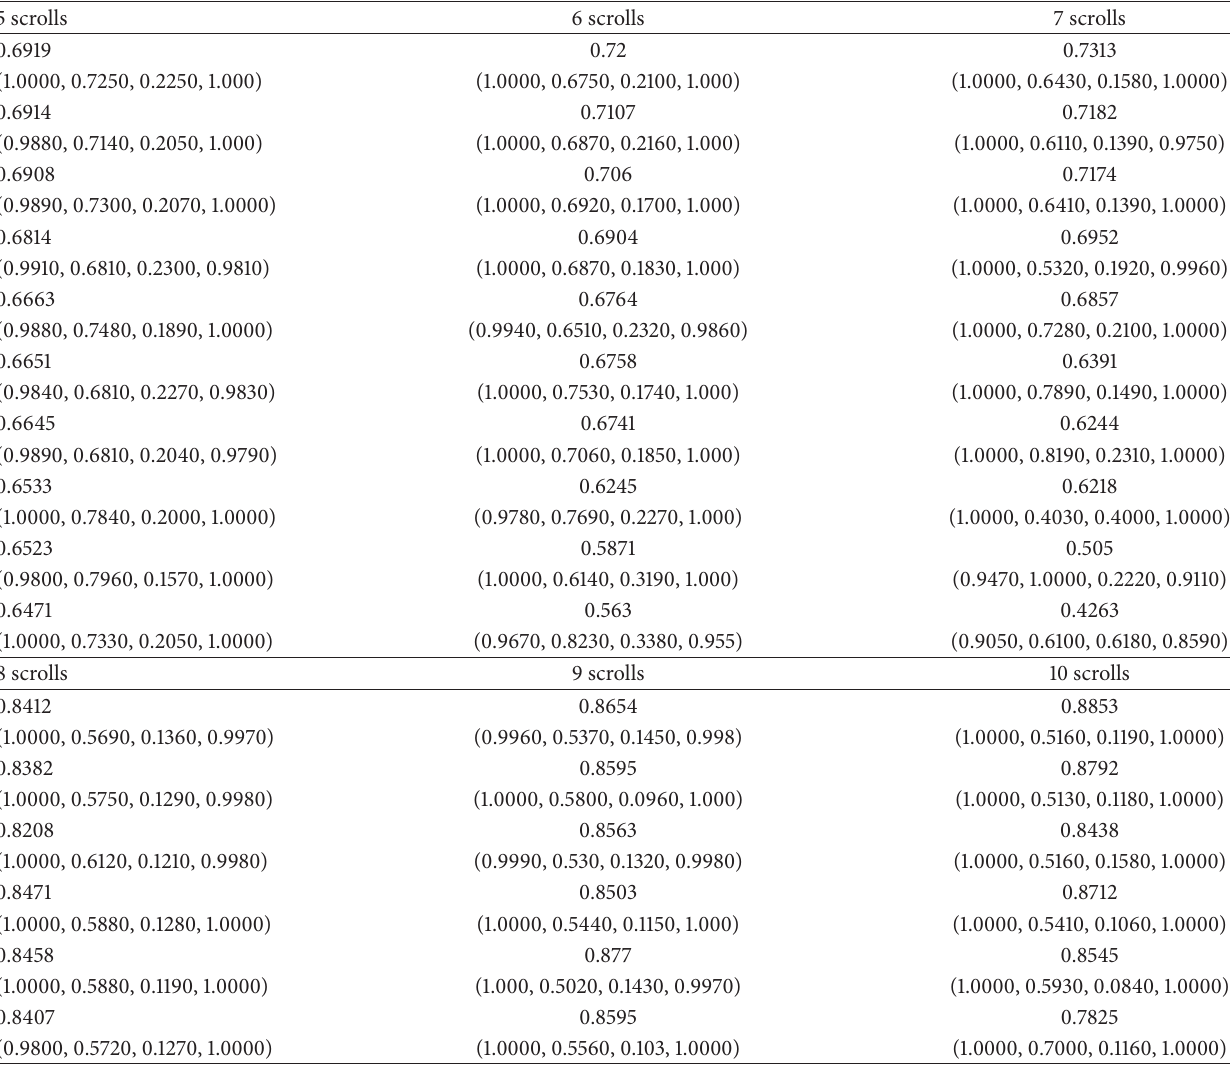
Table 5: Optimized MLE for 5 to 10 scrolls and their (𝑎, 𝑏, 𝑐, 𝑑 1 ) coefficient